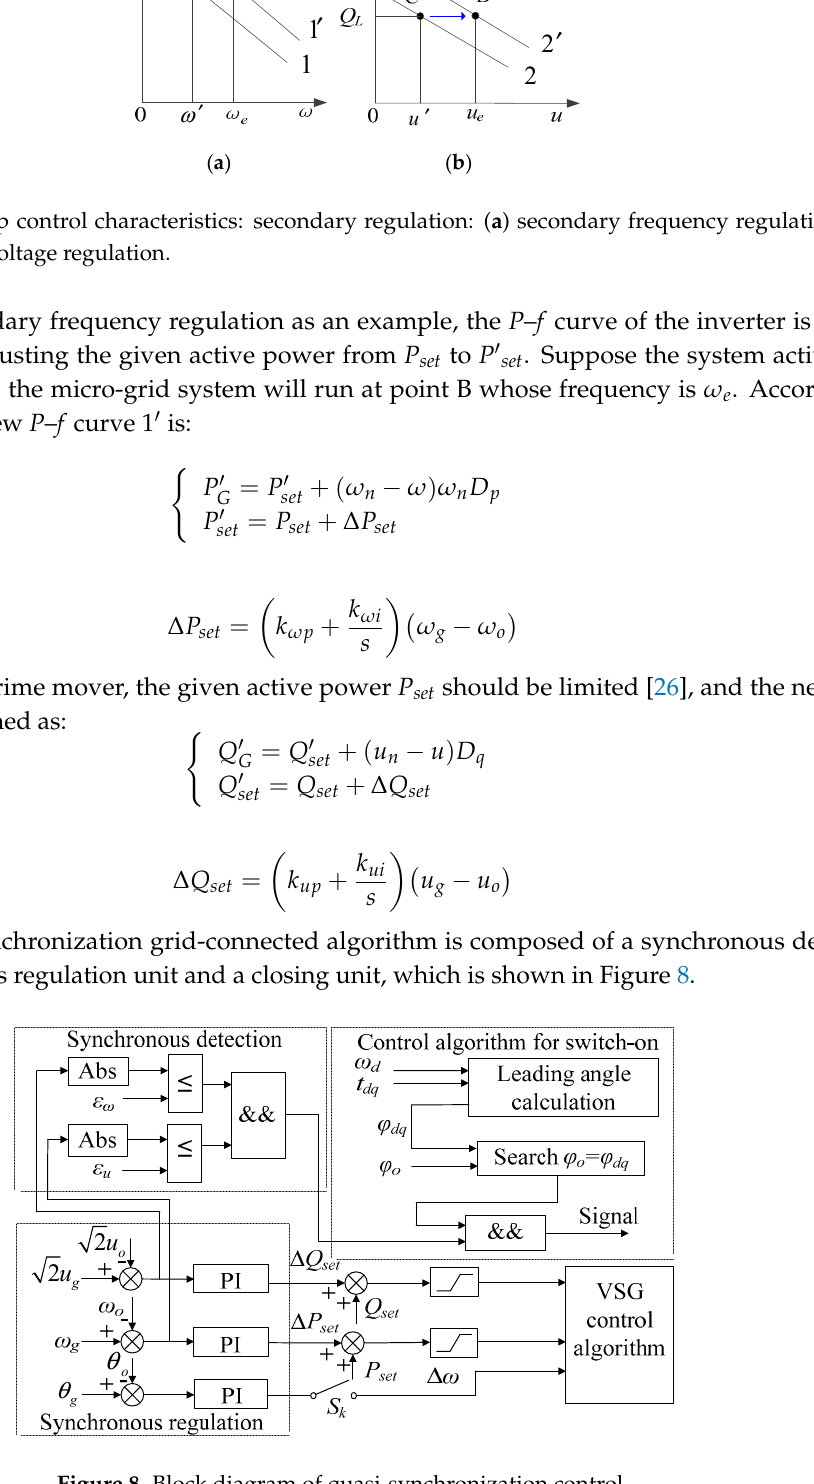
Figure 8. Block diagram of quasi-synchronization control.